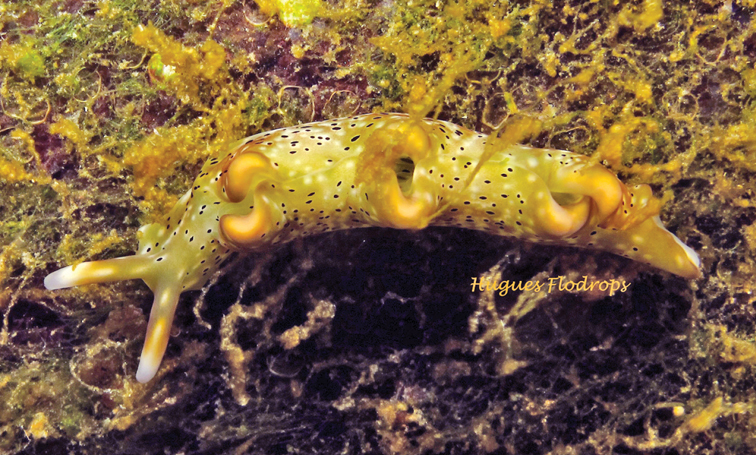
Elysia cf. nigropunctata, 35 mm, La Réunion, photo: H Flodrops (no spcm).